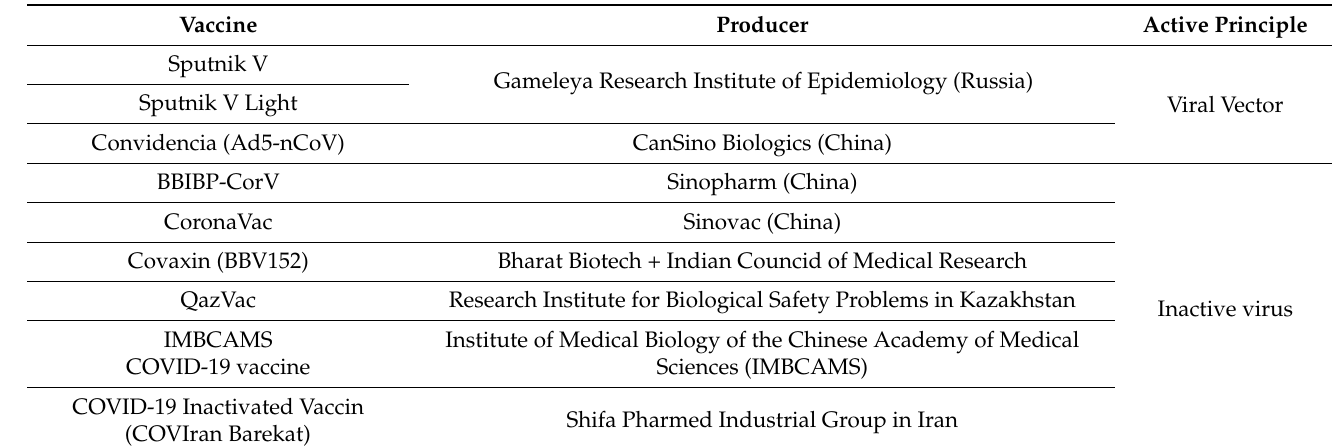
Table 2. Some of the SARS-CoV-2 vaccines used abroad but not approved by the EMA [8–17]. Vaccine